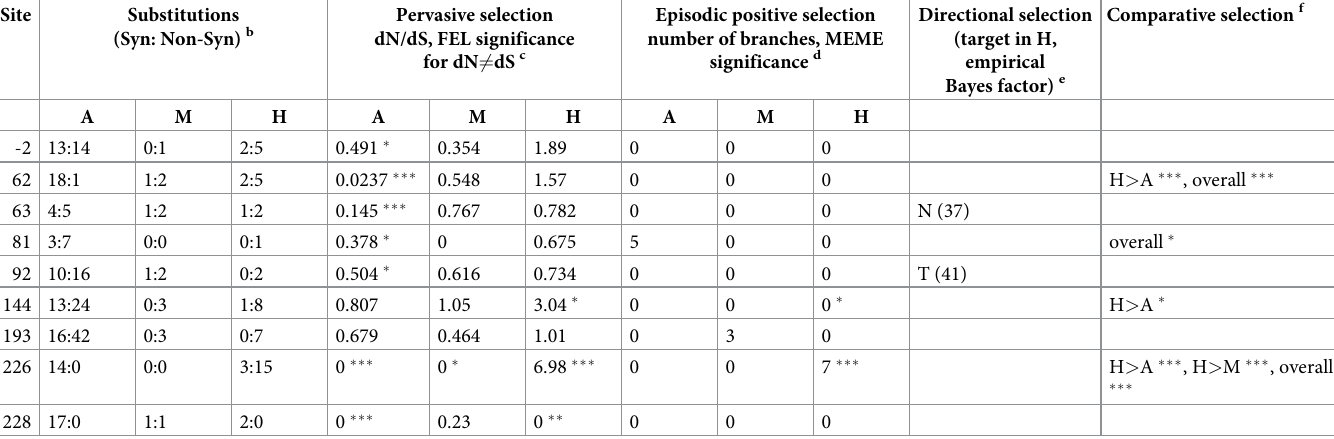
isolated in the years from 1968 to the end of 1999 (set H). We restricted analyses only to internal branches (see Materials and Methods). Asterisks depict significance levels for the tests as follows: � , P < 0.05; �� , P < 0.01; ��� , P < 0.001. b The number of synonymous and non-synonymous substitutions inferred to have occurred on internal branches in the corresponding group set with the SLAC method. c Site-level dN/dS estimate along internal branches in the corresponding group inferred using the FEL method. Asterisks show significance levels for the test that dN 6¼ dS. When significant result is obtained, negative selection is inferred if dN/dS < 1, otherwise diversifying positive selection is inferred. d Site-level characterization of episodic positive selection in the corresponding group inferred using the MEME method. Asterisks show significance levels for the test that dN > dS for some fraction of branches. The number of individual branches where episodic selection may have acted is indicated as well (empirical Bayes factor � 100) e Site-level characterization of directional selection using the DEPS/FADE method. The residue that is the putative target of directional selection is indicated, with empirical Bayes factor supporting directional selection shown. f Site-level characterization of differences in selective pressures between branch groups using the Contrast-FEL method. Asterisks show significance levels for the test that dN/dS differ between pairs of branch groups, or among all branch groups (overall). Notation like H > A means that dN/dS for “human” branches is greater than dN/ dS for “avian” branches. Only significant results are